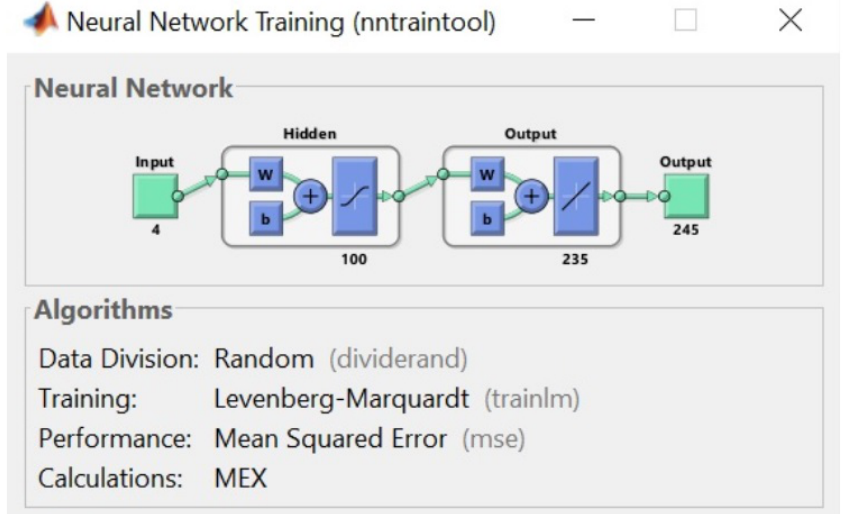
Figure 15. The ANN topology for the 7-DOF model optimization. The input layer contains the variable to optimize: roll angle, pitch angle, sprung mass vertical travel and total weight transfer. The output layer contains the vectors of the designated variables of the optimization. The hidden layer contains the artificial